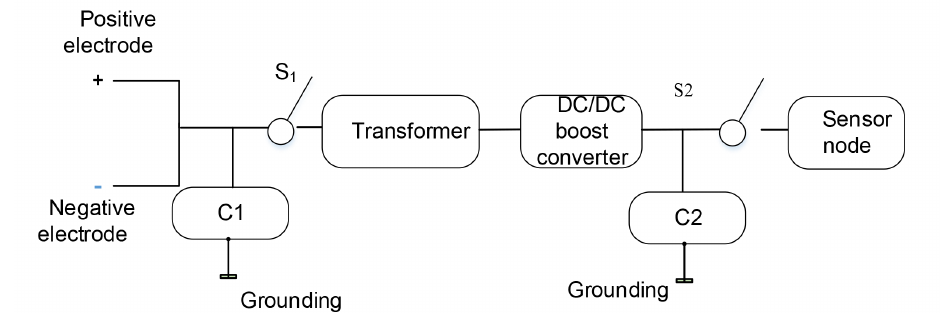
Figure 4. Schematic diagram of the tree-energy generation